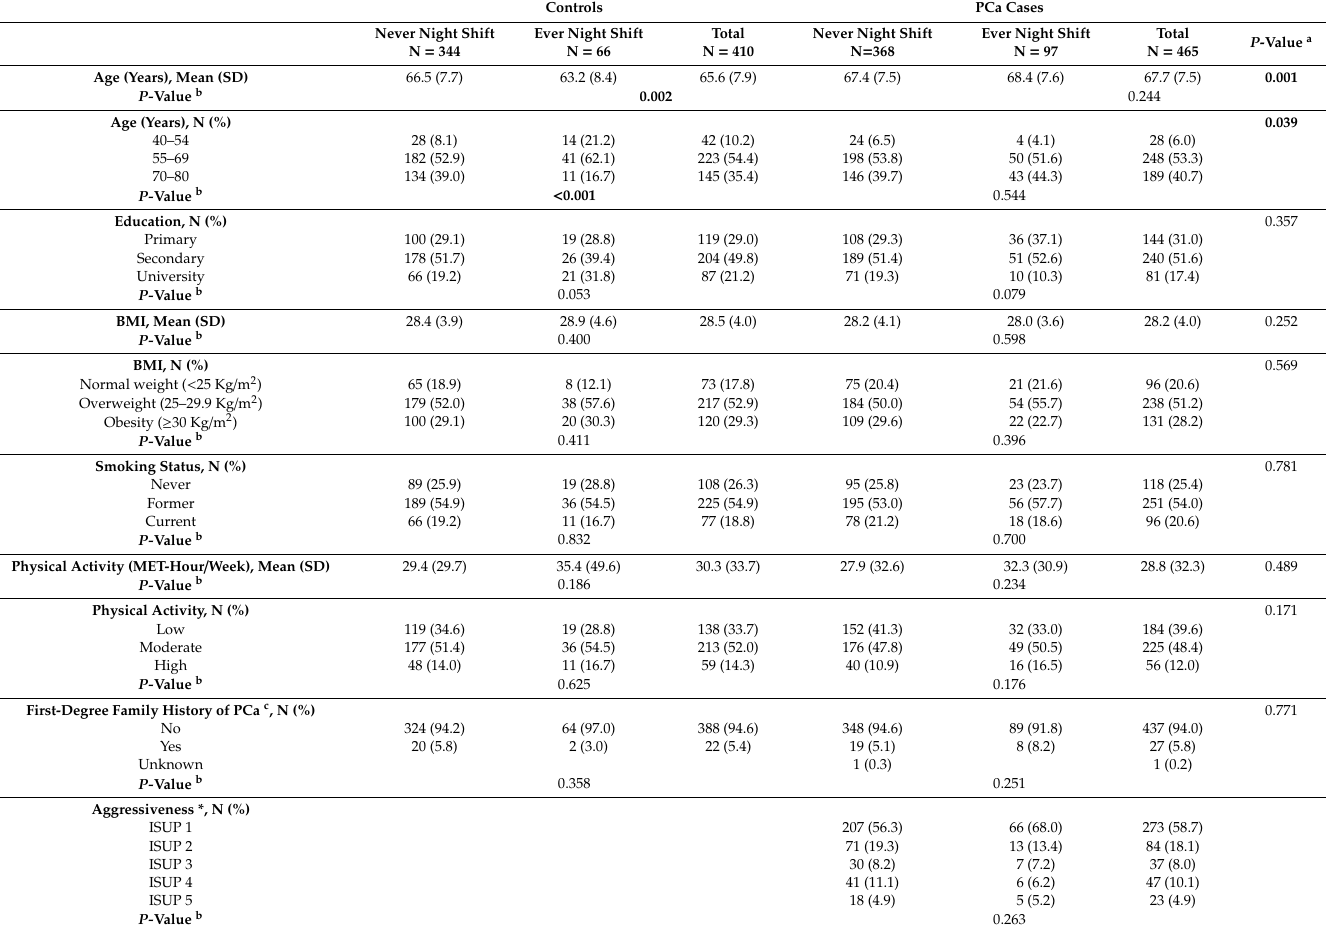
Table 1. Characteristics controls and PCa cases according to having been ever / never night work. CAPLIFE